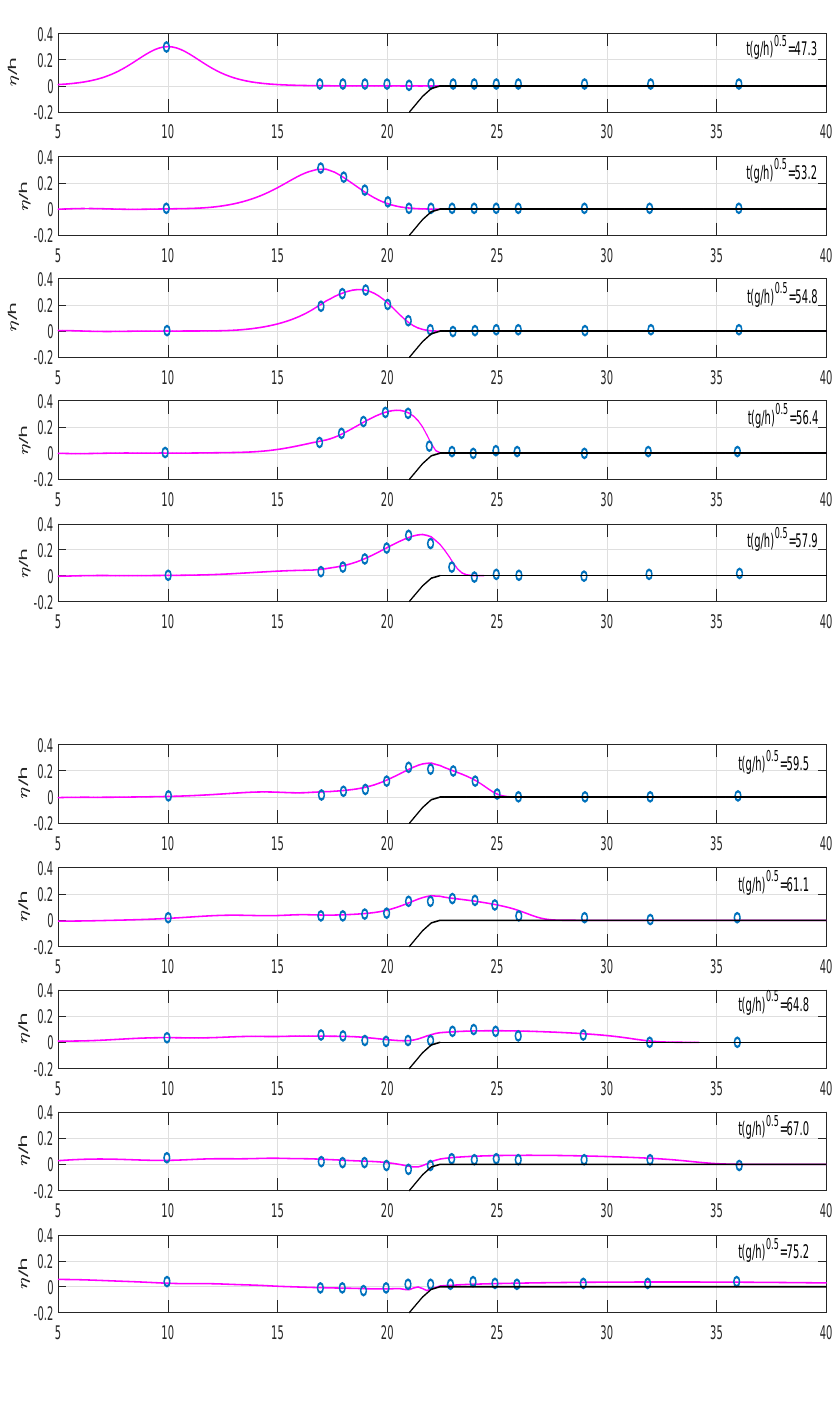
Figure 10. Transformation and surge motion of solitary wave over a fringing reef with A / h = 0.3 and 1/5 slope. Numerical solution (solid line), laboratory data